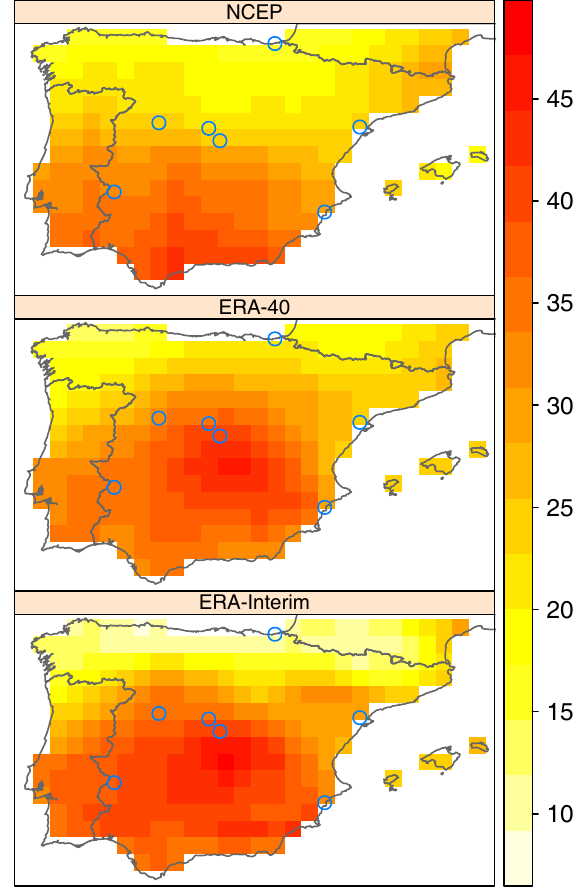
Fig. 6. Spatial distribution of the FWI90 as calculated from dif- ferent datasets in the Iberian Peninsula, using their common pe- riod (1989–2001). Blue circles indicate the locations of the control weather stations, which have been labeled in Fig. 1 according to numeric codes displayed in Table